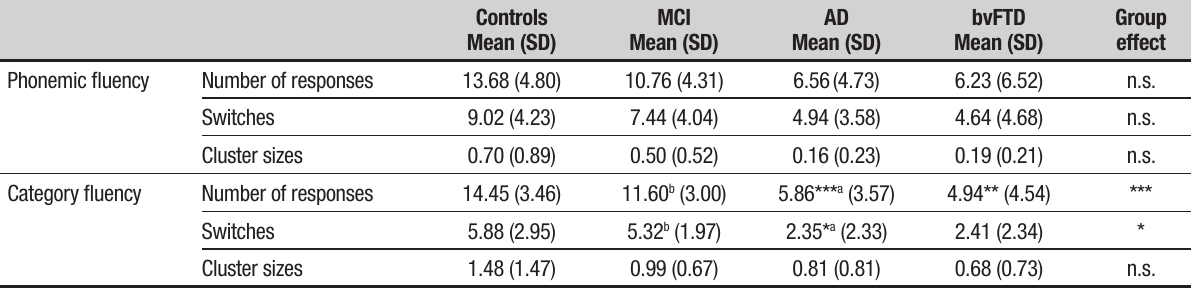
Table 2. Performance on total word output, clustering and switching across different